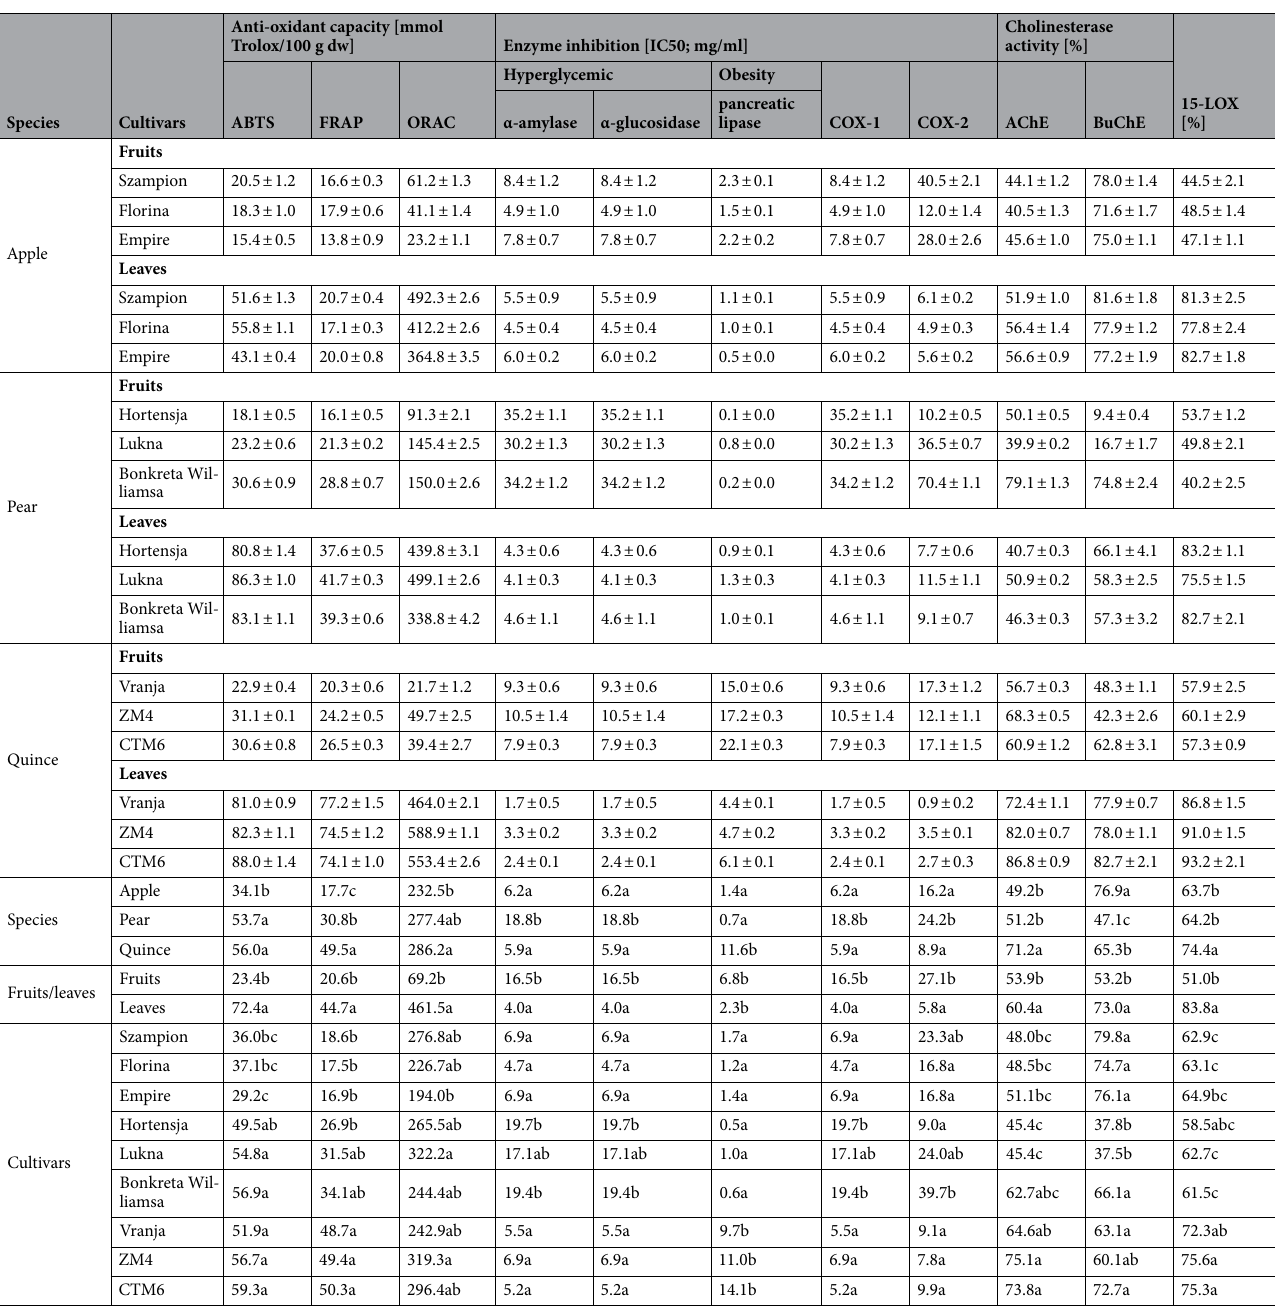
Table 4. Anti-oxidant capacity and inhibition of hyperglycemic, obesity, inflammatory and cholinesterase enzyme, 15-lipooxygenase activity of apple, pear, quince fruits and leaves. Mean of 3 replications ± standard deviation followed by the same letter, within the same column were significantly different (p < 0.05) according to Tukey’s least significant differences test. Letters a,b,c,d, represent significance in content (p <